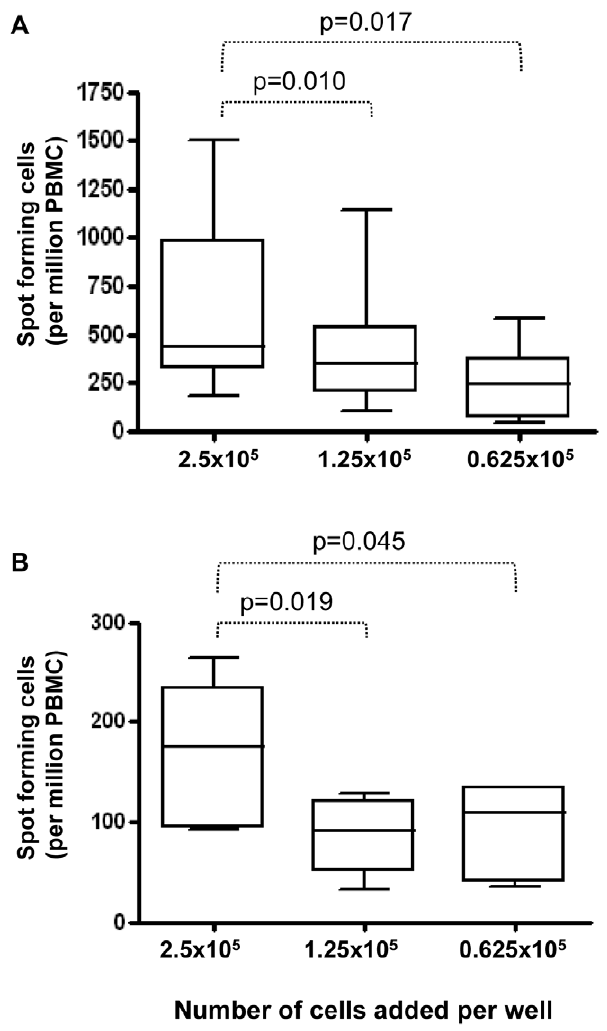
Figure 3. The effect of input PBMC number per well on ELISpot assay performance. Spot numbers in (A) M.tb PPD stimulated, ex vivo ELISpot assays (n=8) or (B) HBHA-stimulated, short-term cultured ELISpot assays (n=6) were determined following the addition of varying PBMC numbers per well. All results were obtained after the subtraction of background spots (measured in unstimulated wells). Box and whisker plots show the median, upper and lower quartiles and range of the response. Data shown are representative of similar experiments carried out in 3 of the 4 laboratories involved. Statistical analysis is by paired